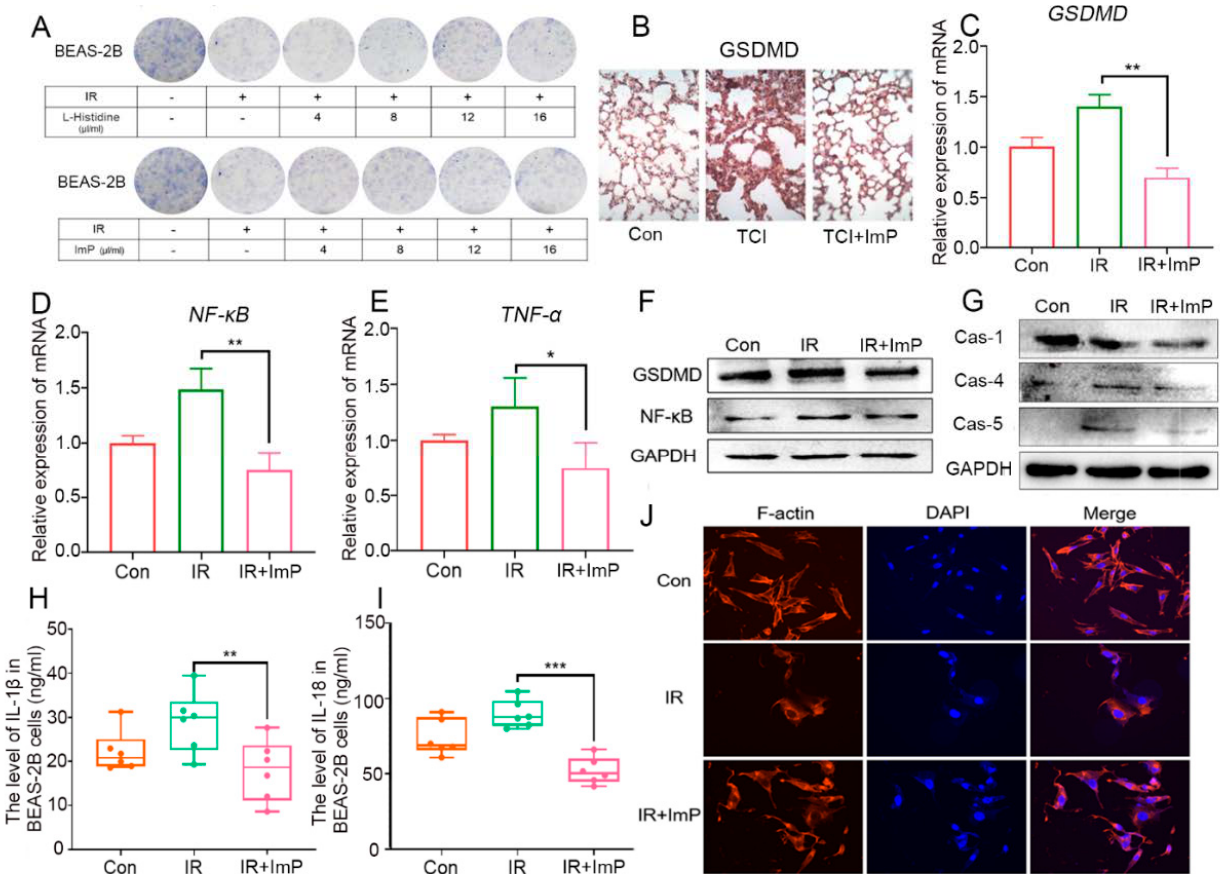
Figure 7. Imidazole propionate inhibits pyrolysis of irradiated lung cells. ( A ) The radiation sensitivity of BEAS-2B cells for L -Histidine and ImP in different densities were assessed through a clone formation experiment after radiation. ( B ) The GSDMD of irradiated lung tissues was analyzed by IHC. ( C ) The GSDMD of irradiated BEAS-2B cells was analyzed by qRT-PCR. ( D , E ) The relative expression of NF- κ B and TNF- α mRNA in irradiated BEAS-2B cells were assessed by qRT-PCR ( n = 6). ( F ) The GSDMD and NF- κ B expression in irradiated BEAS-2B cells were examined by Western blotting. ( G ) The caspase-1, caspase-4, and caspase-5 expression in irradiated BEAS-2B cells were examined by Western blotting. ( H , I ) The level of IL-1 β and IL-18 in irradiated BEAS-2B cells ( n = 6). ( J ) Immunofluorescence showed the F-actin expression in irradiated BEAS-2B cells. (The data are presented as mean ± SD, * p < 0.05, ** p < 0.01 and *** p < 0.001; Student’s t